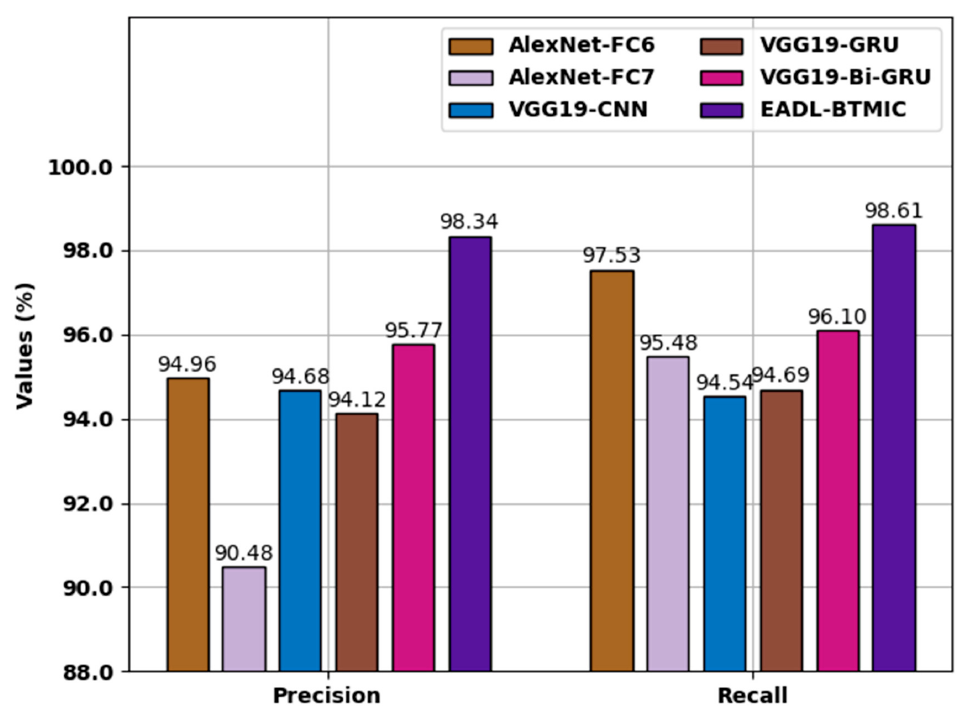
Figure 11. 𝑃𝑟𝑒𝑐 (cid:3041) and 𝑟𝑒𝑐𝑎 (cid:3039) analysis of EADL-BTMIC technique with recent